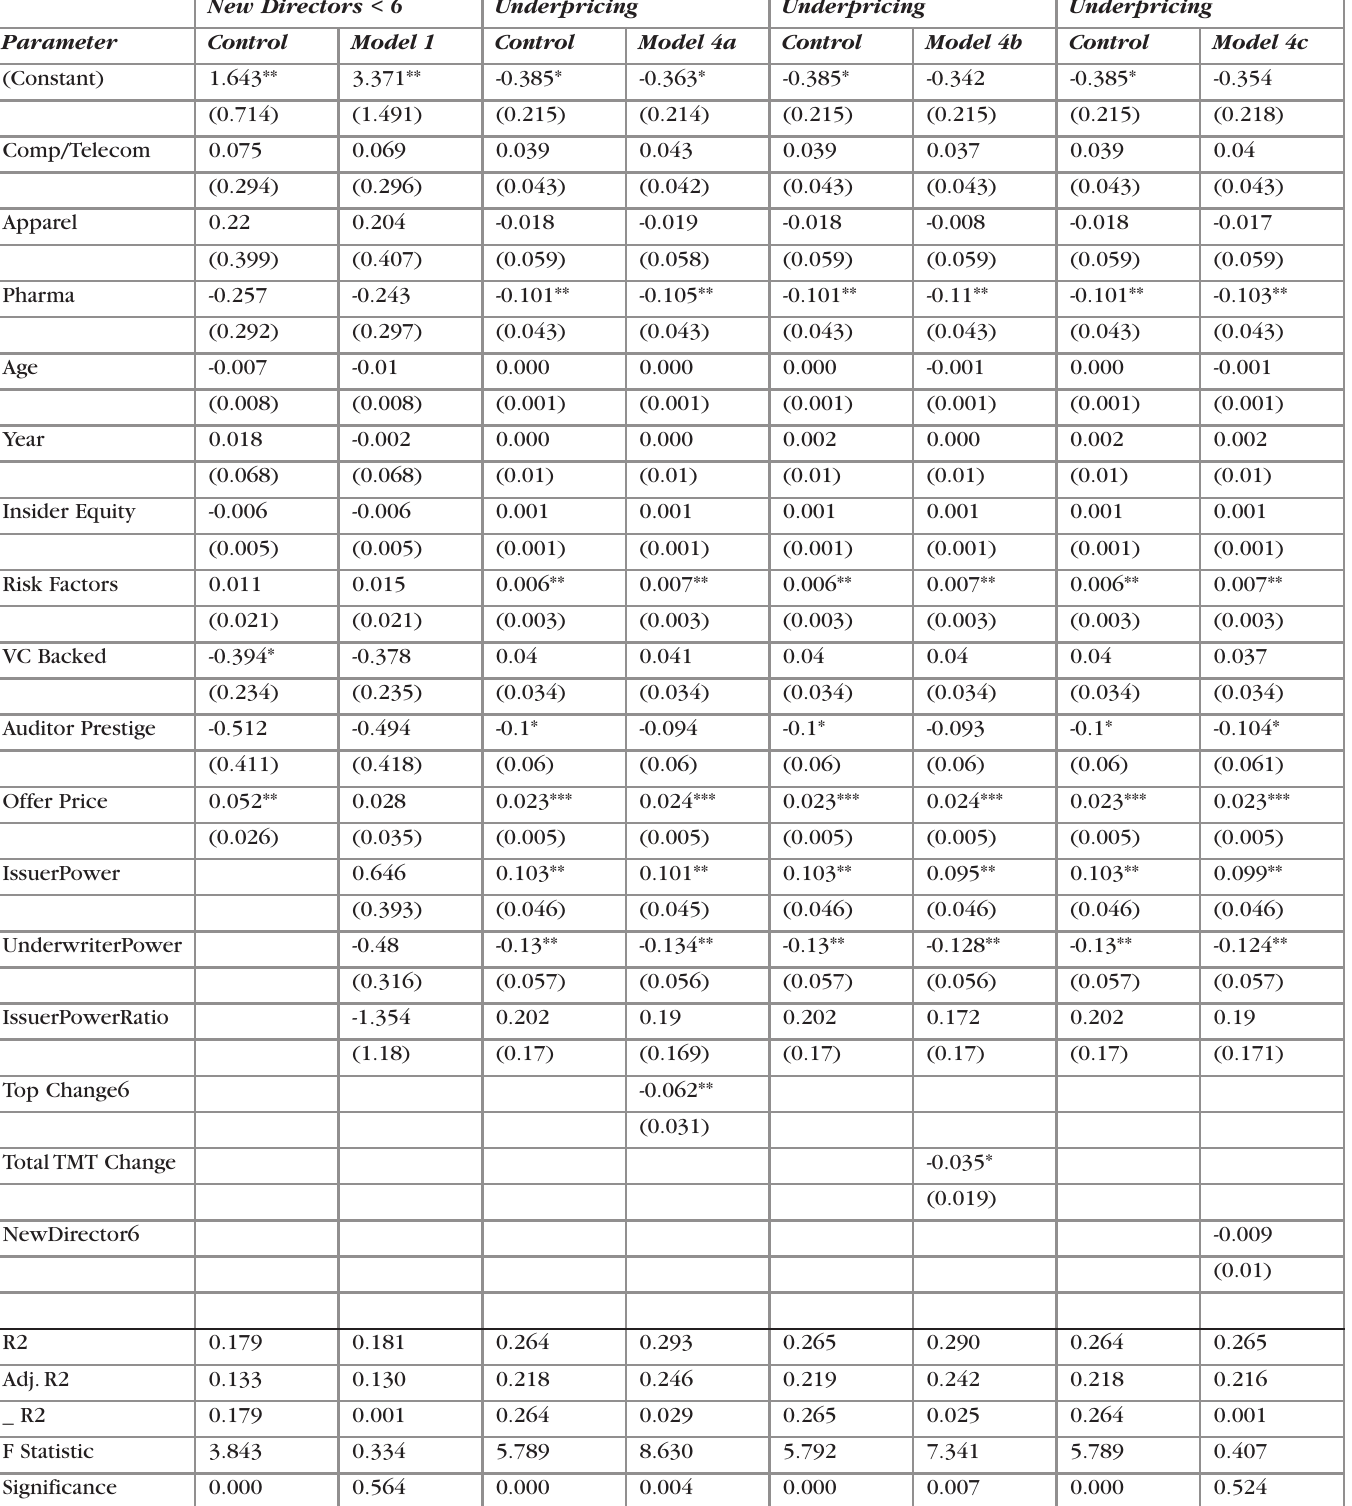
Table 3. Regressions: Dependent Variable New Directors and